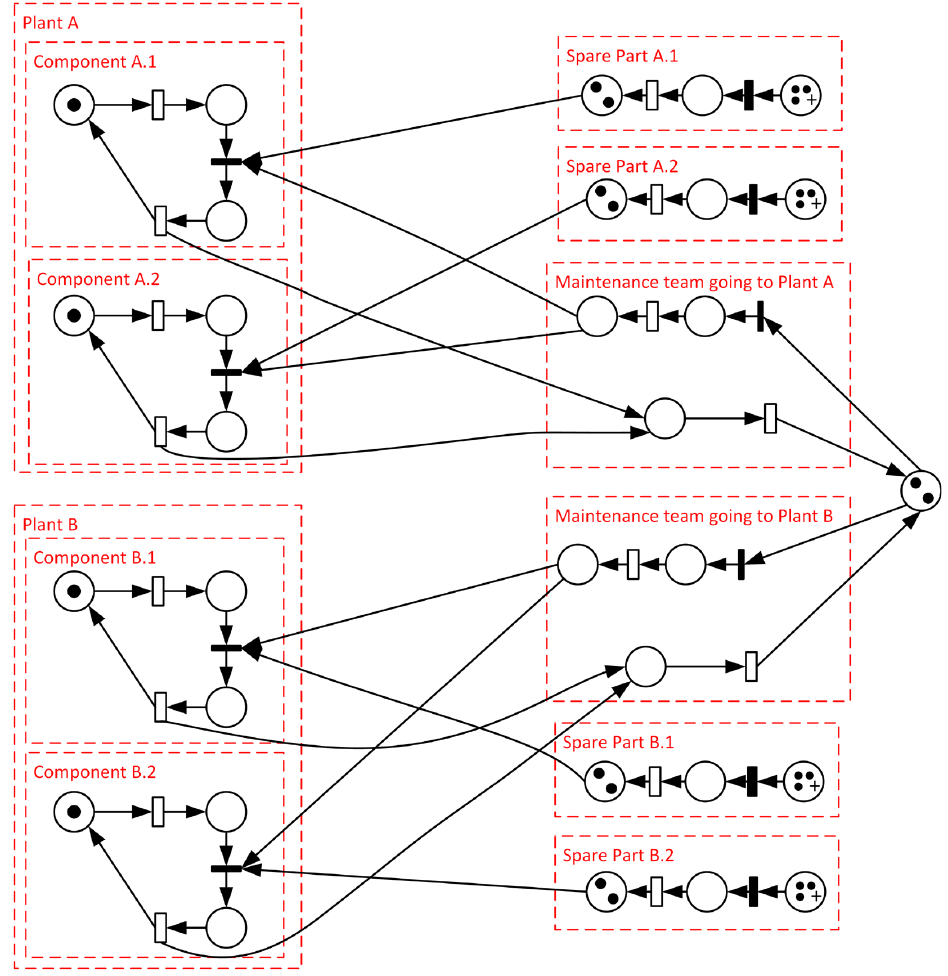
Figure 3. An example of the expansion of the original GSPN